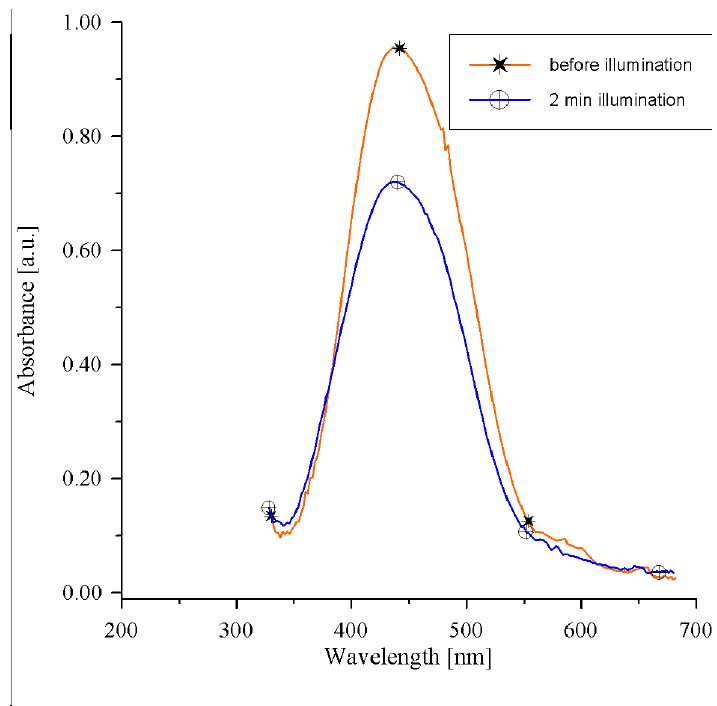
Fig. 5 Absorption spectra of IZO-1 spin-coated › lm on glass plate before and after